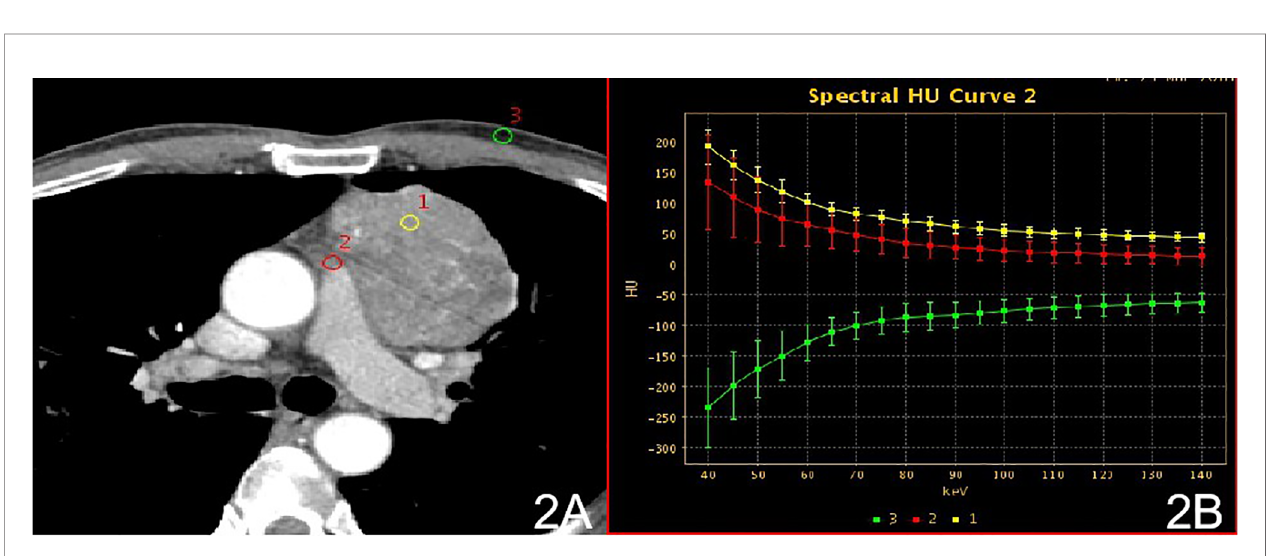
FIGURE 2 | Stage II, (A) 70 keV single-energy CT value of the arterial phase is used to outline the ROI of the lesion; (B) arterial lesion spectrum (yellow), extra-focal fat spectrum (red) and anterior chest wall fat spectrum